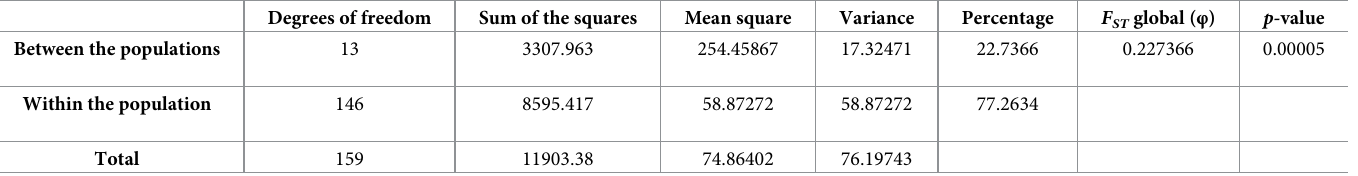
Table 3. Analysis of molecular variance (AMOVA) based on 929 neutral SNP markers for fourteen natural populations of C . prunifera . Degrees of freedom Sum of the squares Mean square Variance Percentage F ST global ( φ ) p -value Between the populations 13 3307.963 254.45867 17.32471 22.7366 0.227366 0.00005 Within the population 146 8595.417 58.87272 58.87272 77.2634 Total 159